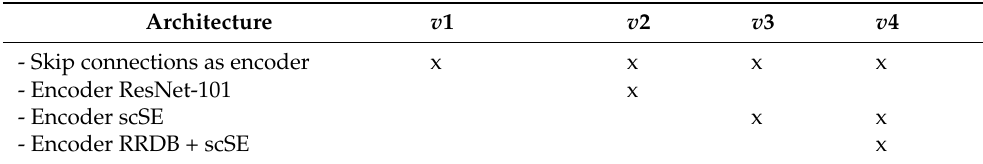
Table A1. Different versions of the SEG-ESRGAN architecture. Architecture